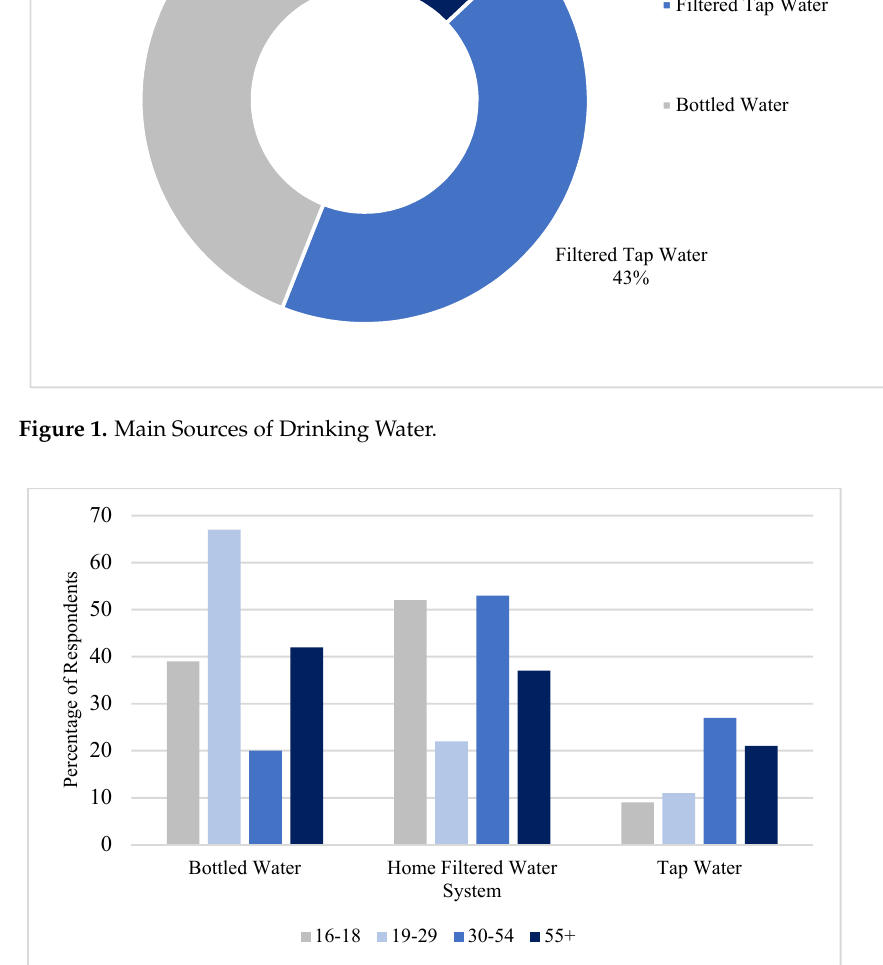
Figure 2. Tap Water Preference by Age.